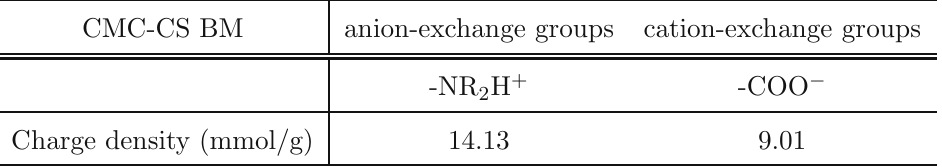
Table 2 Charge density of different functional groups in CMC-CS